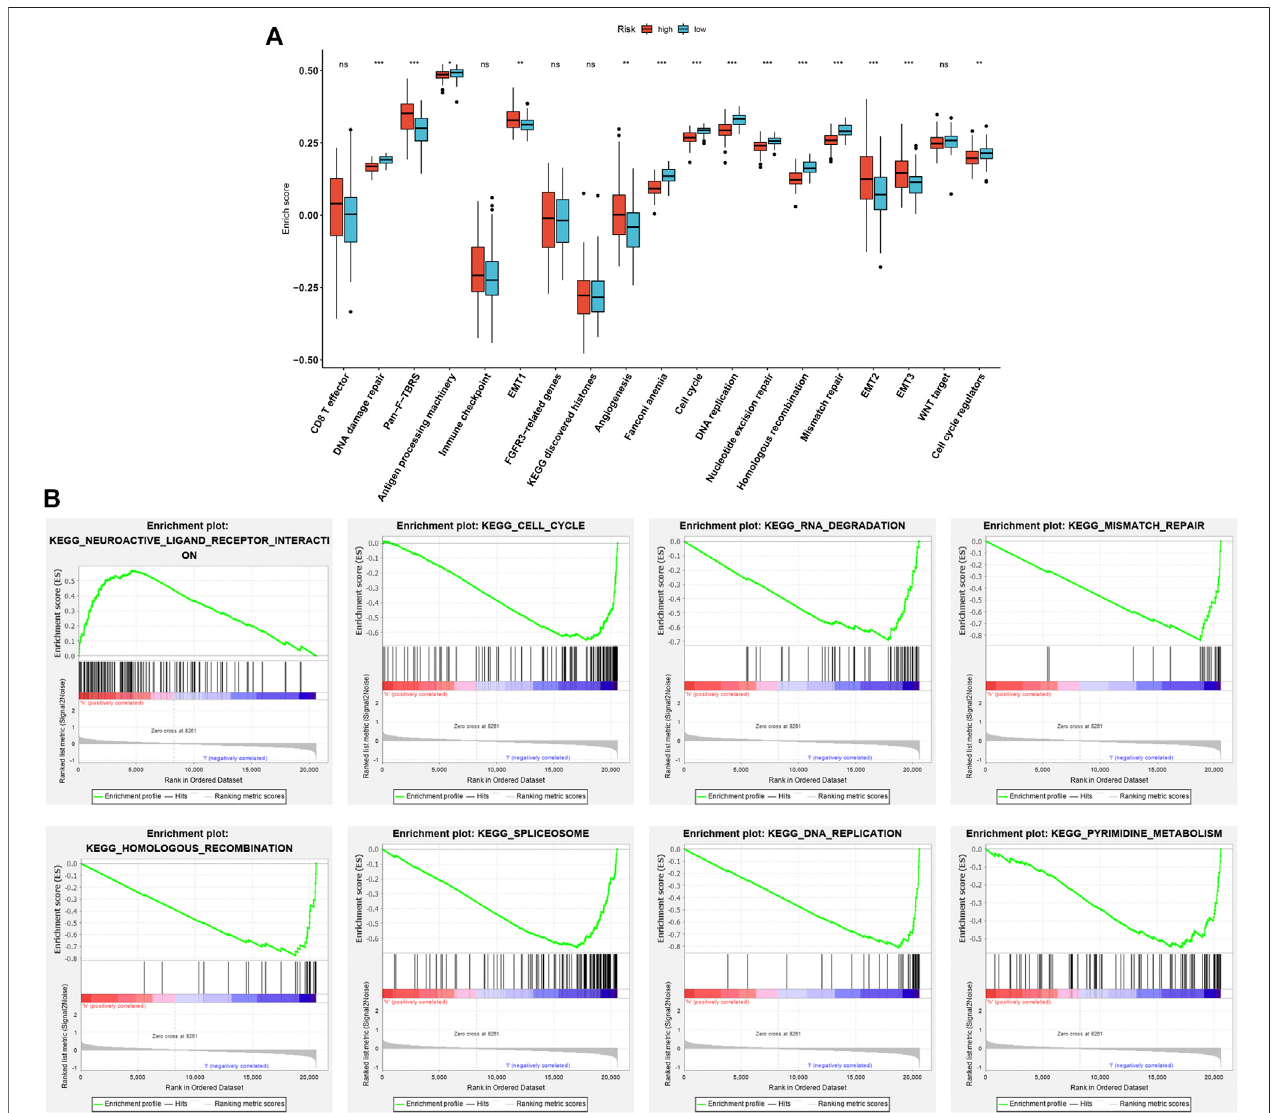
FIGURE 5 | Association of aging-related gene signature with stromal activation in the discovery set. (A) Comparisons of the activation of known biological processes in high- and low-risk patients. (B) GSEA results for KEGG pathways associated with aging-related gene signature. Ns: not signi fi cant; * p < .05; ** p < .01; *** p <